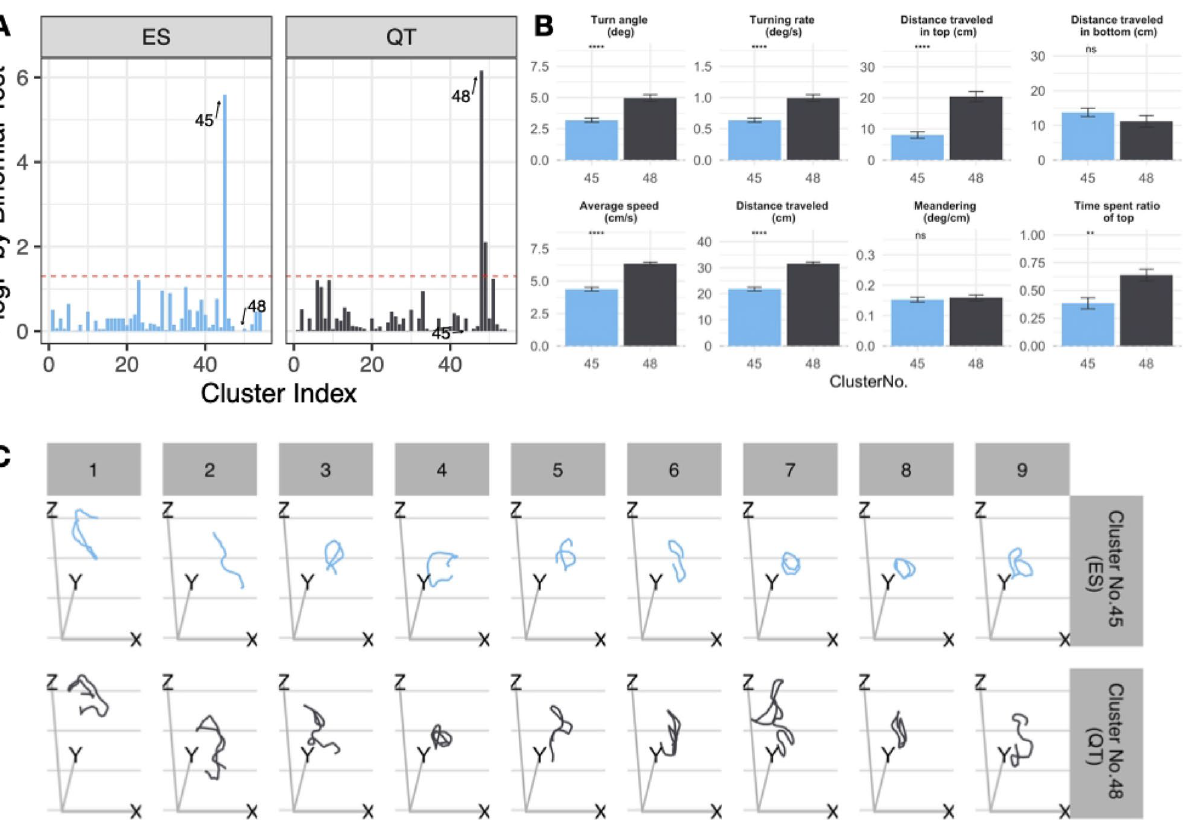
Figure 5. Behavioral features identified by machine learning. ( A ) Correlations between the cluster of behavior features and treatment of the optimal parameter values found by grid search (shown in Fig. 4) in 5 s time segment behavior. Cluster no. 45 was significantly associated with treatment (ES phase); cluster no. 48 was significantly associated with no treatment (QT phase). The cluster identifier number is shown on the x-axis, and -log p-values are indicated on the y-axis. The horizontal red dashed line shows a p-value of 0.05 by binomial test (the probability of correlation was not significantly different from 0.5 for each of the clusters). ( B ) Exploratory behavioral profiles of zebrafish between cluster no. 45 (ES phase) and cluster no. 48 (QT phase), which were newly identified by the clustering analysis. ( C ) Reconstruction and visualization of the 3D swim path of adult zebrafish between cluster no. 45 (ES phase) and cluster no. 48 (QT phase). Because of the limitation of the picture size, only 9 motion tracks in each behavior feature are displayed. Data are shown as the mean ± SEM for zebrafish (n = 10, Student’s t-test), with p < 0.05 and p < 0.01 represented by * and **,